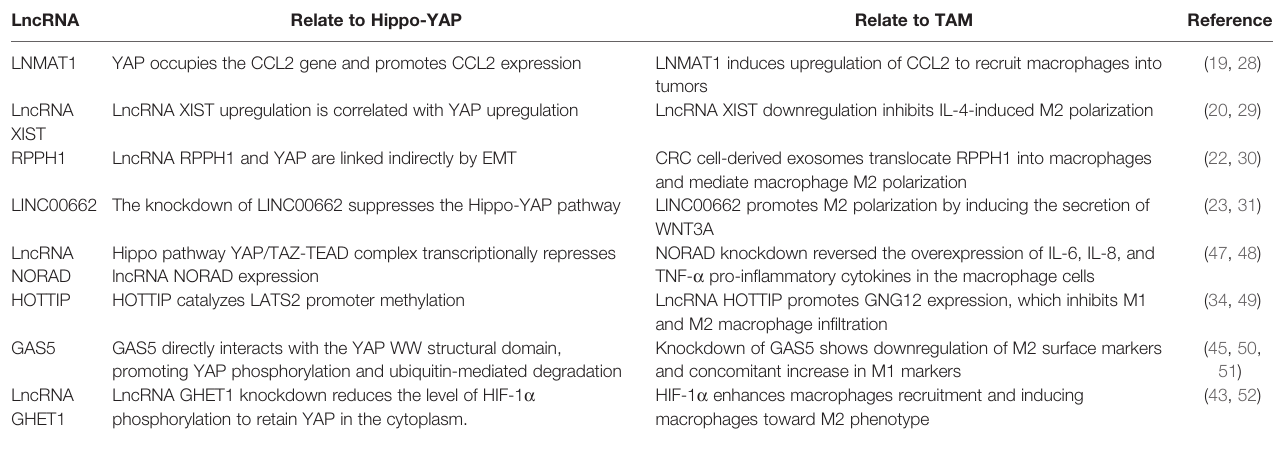
TABLE 3 | Direct or indirect crosstalk among YAP, LncRNA, and